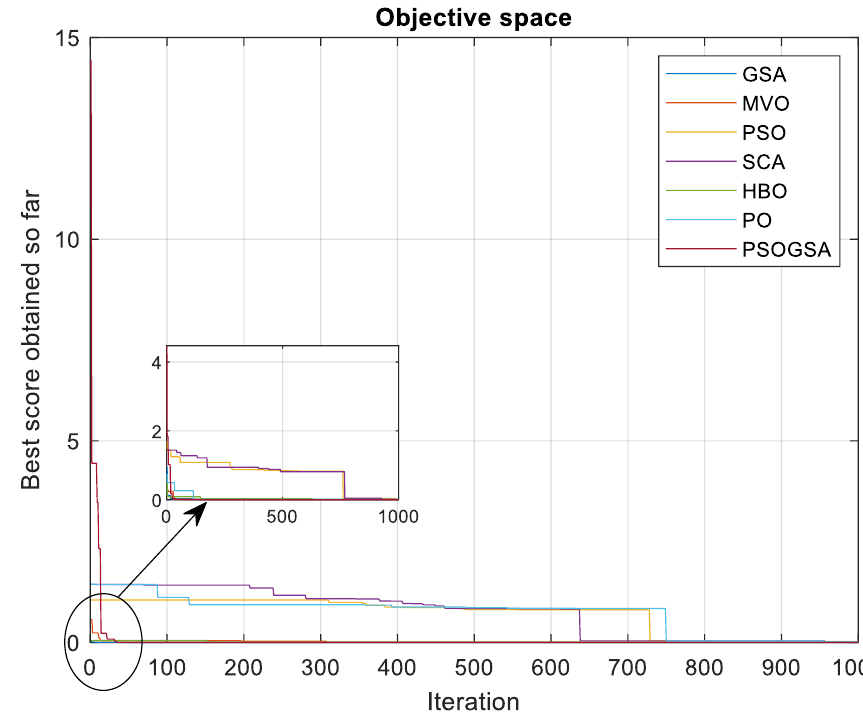
Figure 12. The convergence curve of the polycrystalline MDDM . Table 15. The MDDM calculation error, mean and standard deviation for Case 2 .